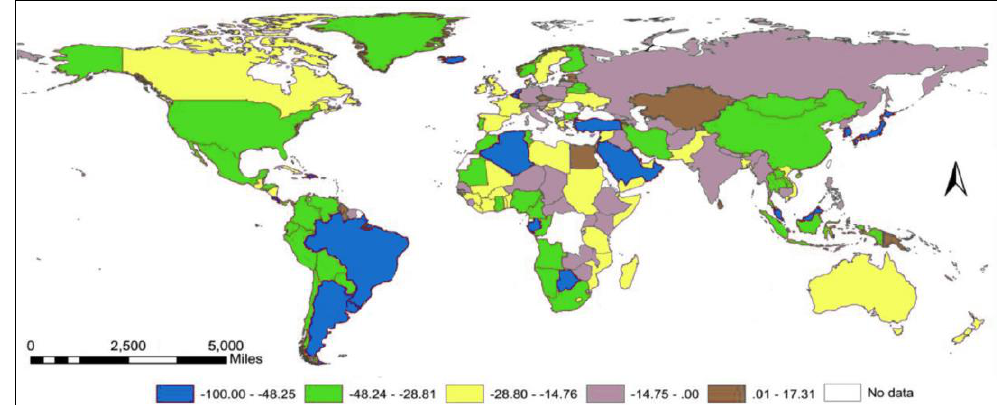
Fig. 1. Changes in the proportions (%) of the rural population (Source: Own elaboration based on the work of Li et al.,